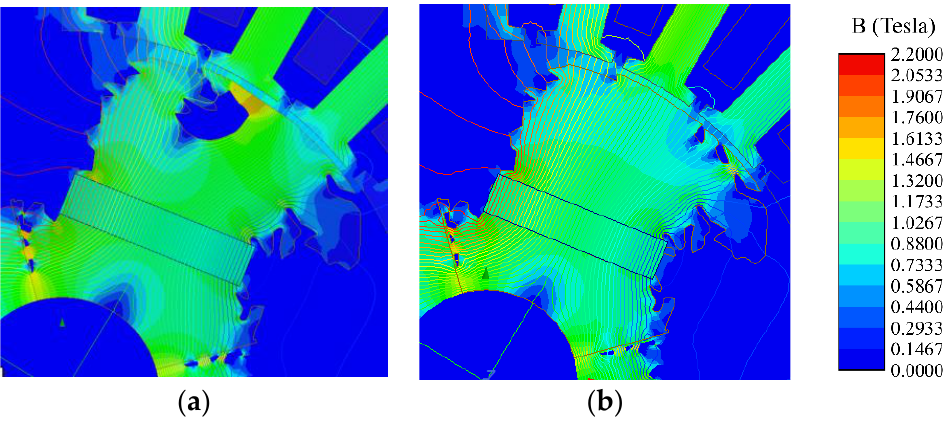
Figure 13. Magnetic flux line of optimal model 0 ( a ) and model 1 ( b ).